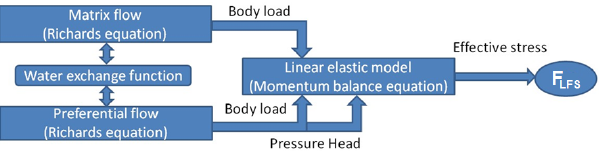
Figure 1. Structure of coupled dual-permeability model and soil mechanics model.